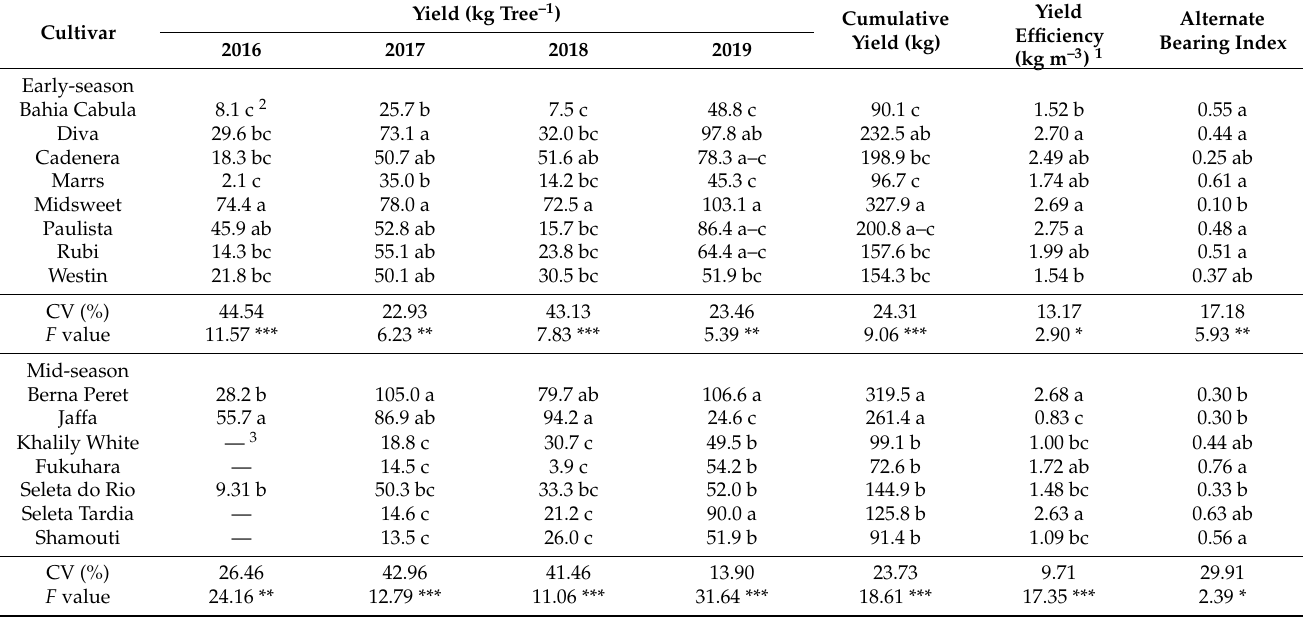
Table 3. Annual yield, cumulative yield, yield efficiency, and alternate bearing index of 15 early- season and mid-season sweet orange cultivars from 2016 to 2019 in Guairaç á , Paran á , Brazil. Yield (kg Tree –1 Cultivar